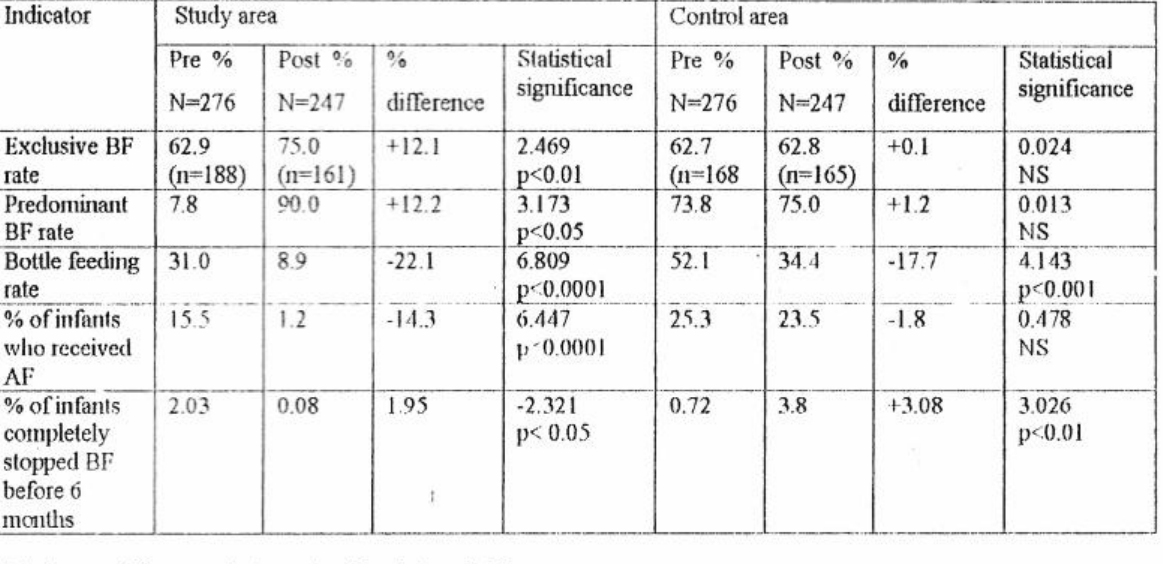
Percentage change ininfant feeding practices in the studyand control areas ~ pre and postintervention